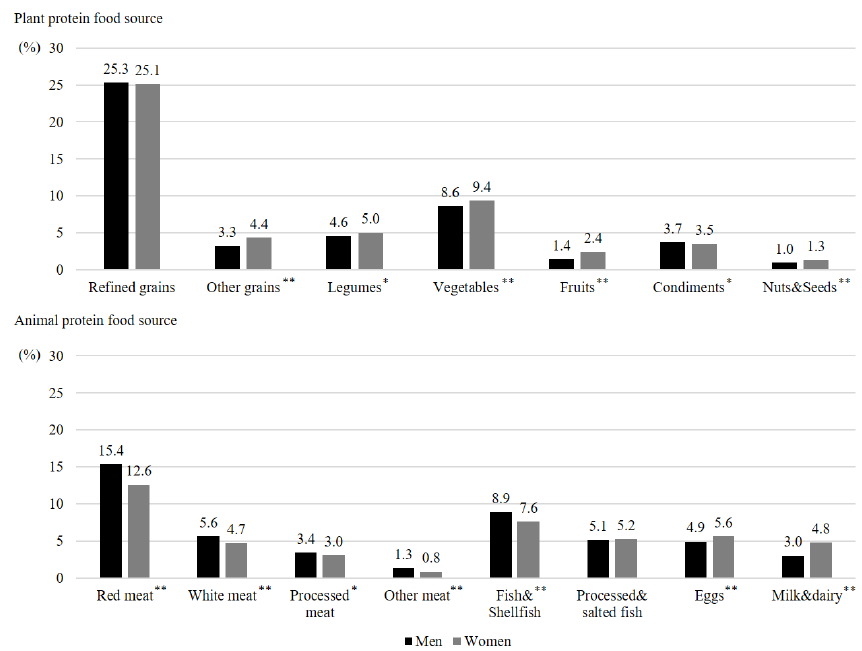
Figure 1. The proportion of protein intake from plant and animal food sources among total protein intake by each food group in Korean adults aged 30–64 years. p -values derived from Student’s t -test represent di ff erences between men and women (* p < 0.05, ** p <